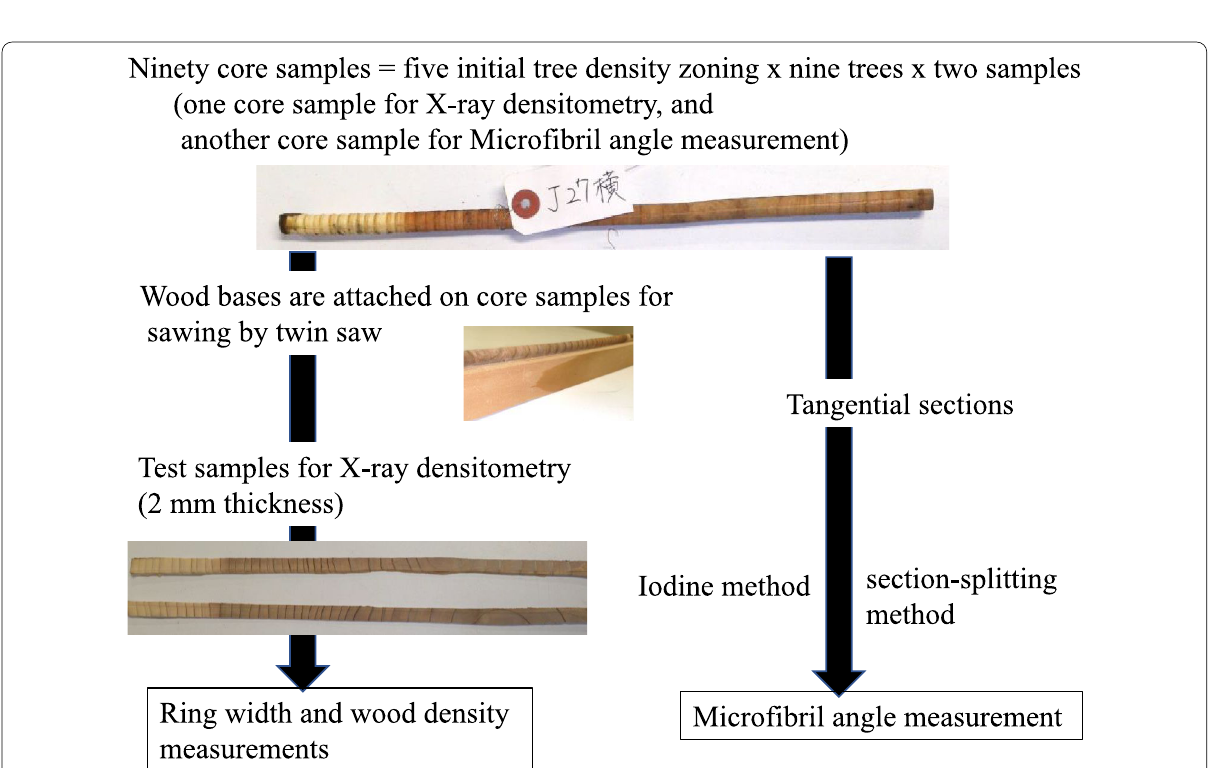
Fig. 1 Samples for X-ray densitometry and Microfibril angle